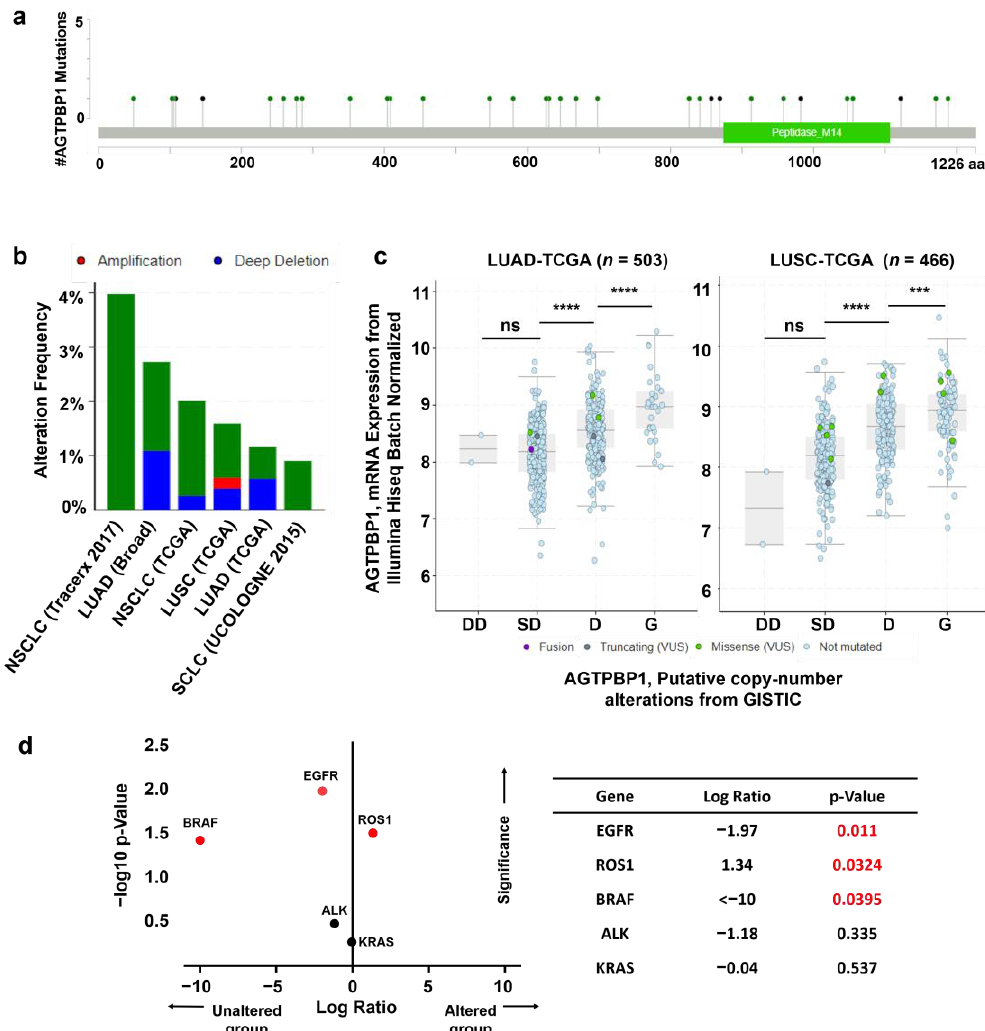
Figure 4. Mutation and copy number alterations (CNAs) of ATP / GTP binding protein 1 ( AGTPBP1 ) in lung cancer, as determined using the cBioPortal. ( a ) Mutation diagram of protein domains between amino acids 0 and 1266 of AGTPBP1 . ( b ) Alteration frequency of AGTPBP1 obtained from 17 lung cancer studies with a total of 4624 samples. The sample threshold was set > 100 and the alteration frequency was > 0.5%. ( c ) Correlation between AGTPBP1 expression and CNAs in LUAD ( n = 503) and LUSC ( n = 466) in TCGA PanCancer dataset. LUAD, lung adenocarcinoma; LUSC, lung squamous cell carcinoma; DD, deep deletion; SD, shallow deletion; D, diploid; G, gain. (ns: non-significant; ***: p < 0.001; ****: p < 0.0001). ( d ) Co-occurrence pattern of mutation between AGTPBP1 and some relevant biomarkers, EGFR , ROS1 , BRAF , ALK , and KRAS . Log2-based ratio of mutated gene in AGTPBP1 altered group to unaltered group was expressed along the x -axis and log10 p -values was expressed along the y -axis. Red—colored dots indicate genes with significant co-occurrence with p -value less than 0.05. NSCLC: non-small cell lung carcinoma, SCLC: small cell lung carcinoma, TCGA: The Cancer Genome Atlas.